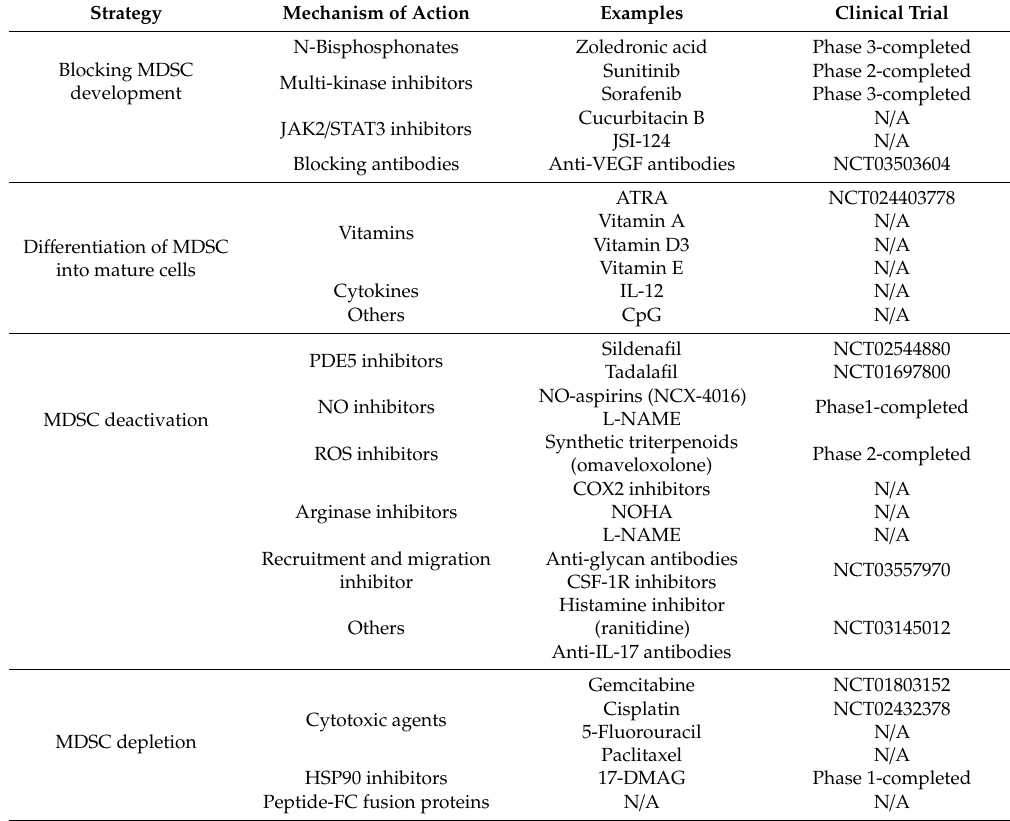
Table 2. Strategies for myeloid-derived suppressor cell (MDSC)